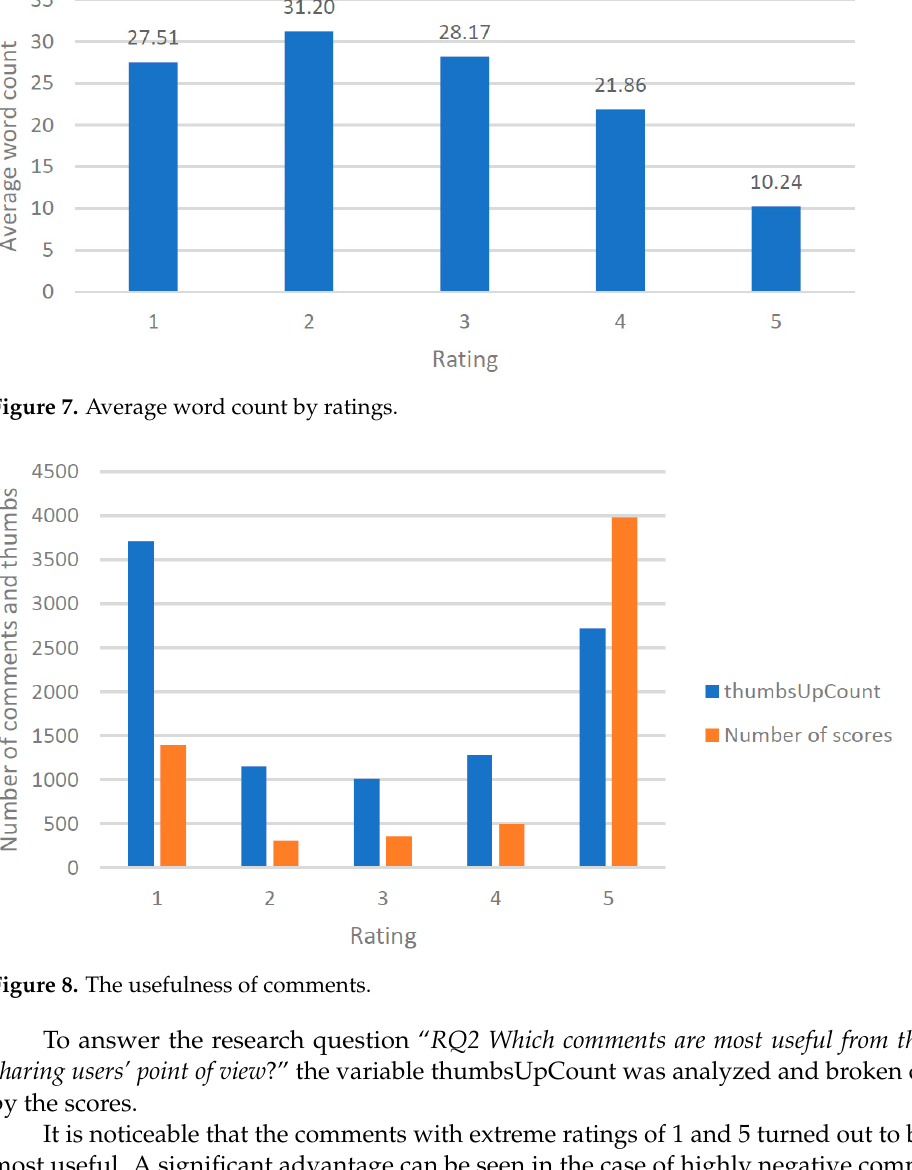
Figure 9. Polarity of comments. Green—positive, red—negative. A more detailed analysis with the CLARIN-PL tool allows you to extract phrases re- lating to positive emotions (such as joy, trust, and looking forward to something unex- pected) and negative (sadness, anger, fear, disgust, and negative surprise), as well as pos- itive and negative features. The results of the analysis are presented in Figures 10 and 11.